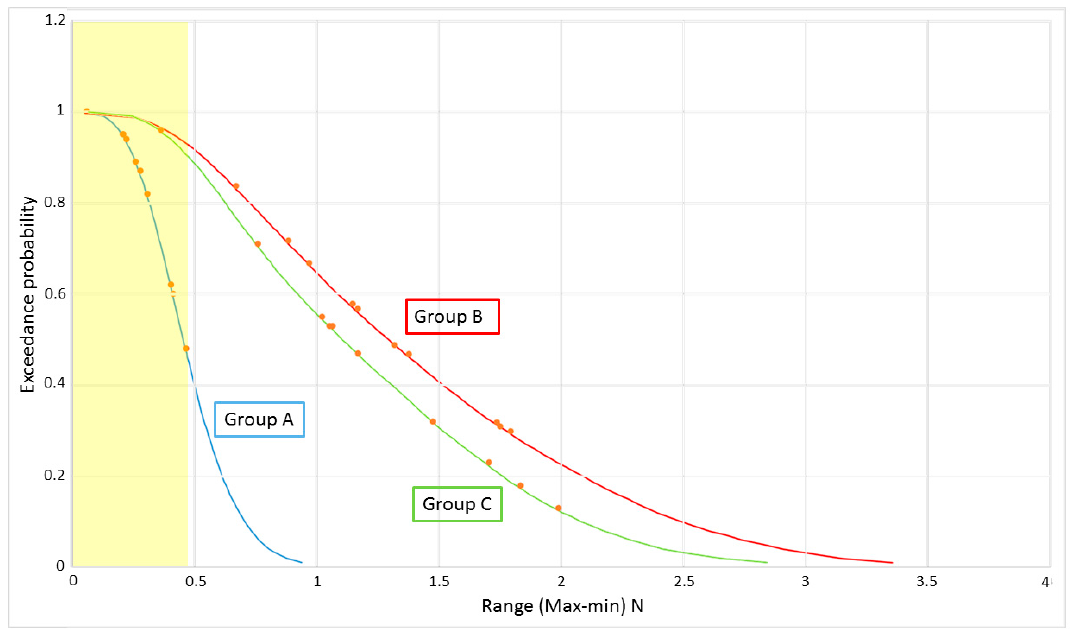
Figure 13. Exceedance plots for front line load error ranges for Groups A, B, and C. Table 6. Front line load 𝑷 𝟓𝟓 values.